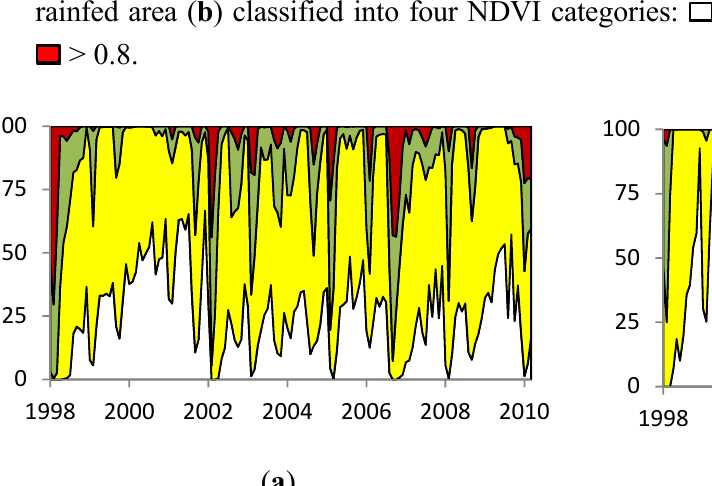
Figure 11. Fraction (%) of the inundated part of the Lorian Swamp ( a ) and the surrounding rainfed area ( b ) classified into four NDVI